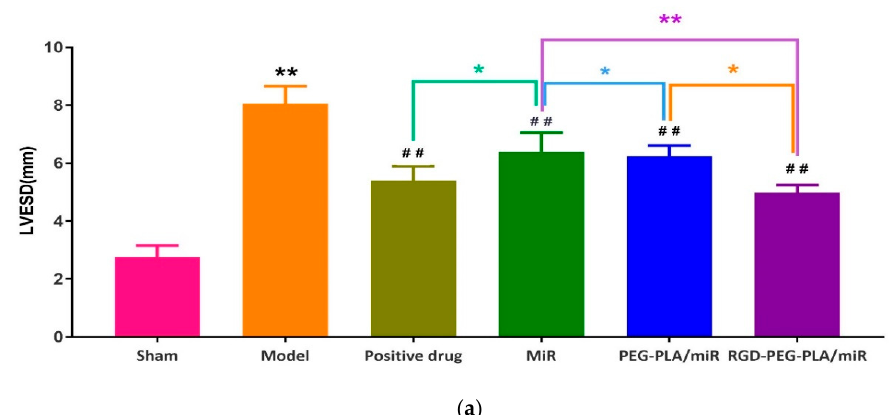
Figure 4. Electrocardiogram results in ( a ) the sham group, ( b ) the model group, ( c ) the positive drug group, ( d ) the miR-133 group, ( e ) the PEG-PLA/miR-133 group, and ( f ) the RGD-PEG-PLA/miR-133 group of rats.